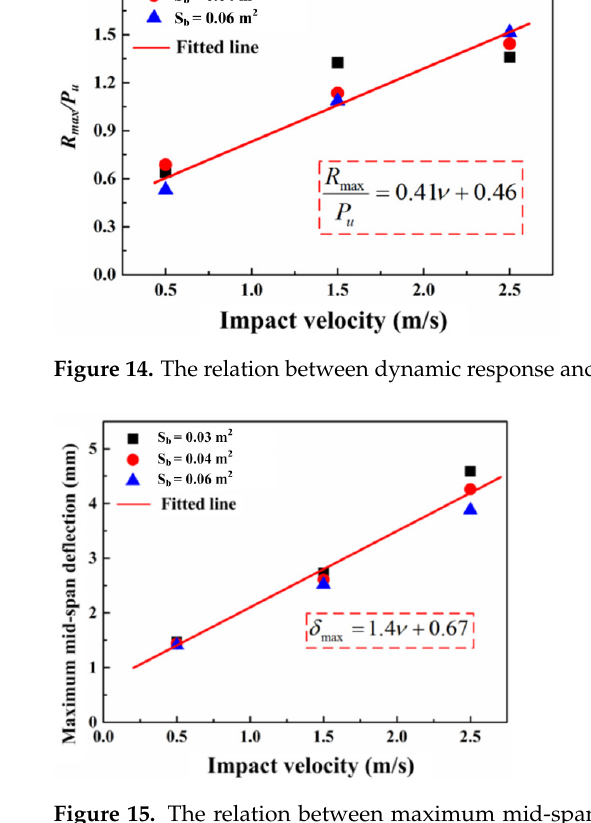
Figure 15. The relation between maximum mid-span deflection and ( a ) reaction force or ( b ) the number of steel bars.